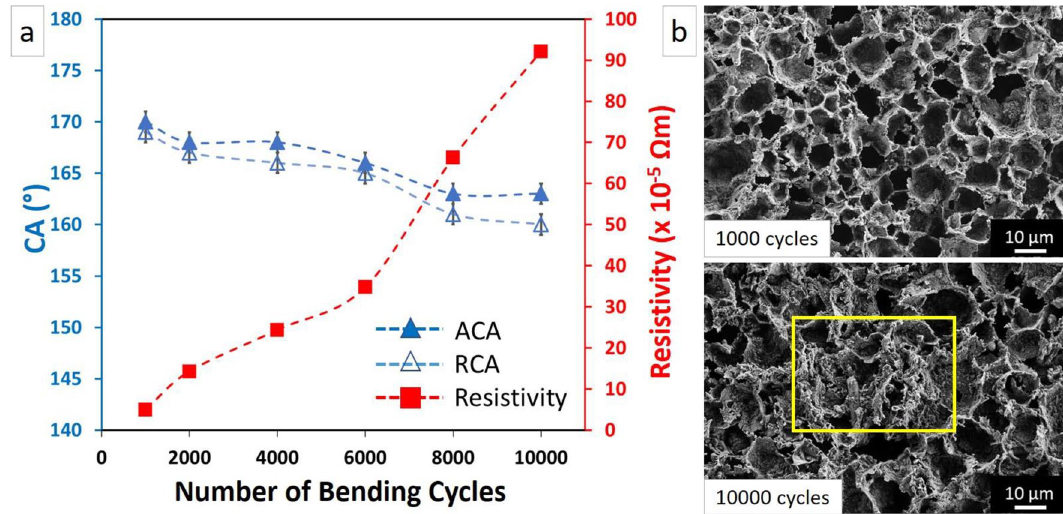
Figure 6. ( a ) The advancing, receding contact angles and resistivity after 10,000 bending cycles. ( b ) The SEM images of samples after 1000 and 10,000 cycles of